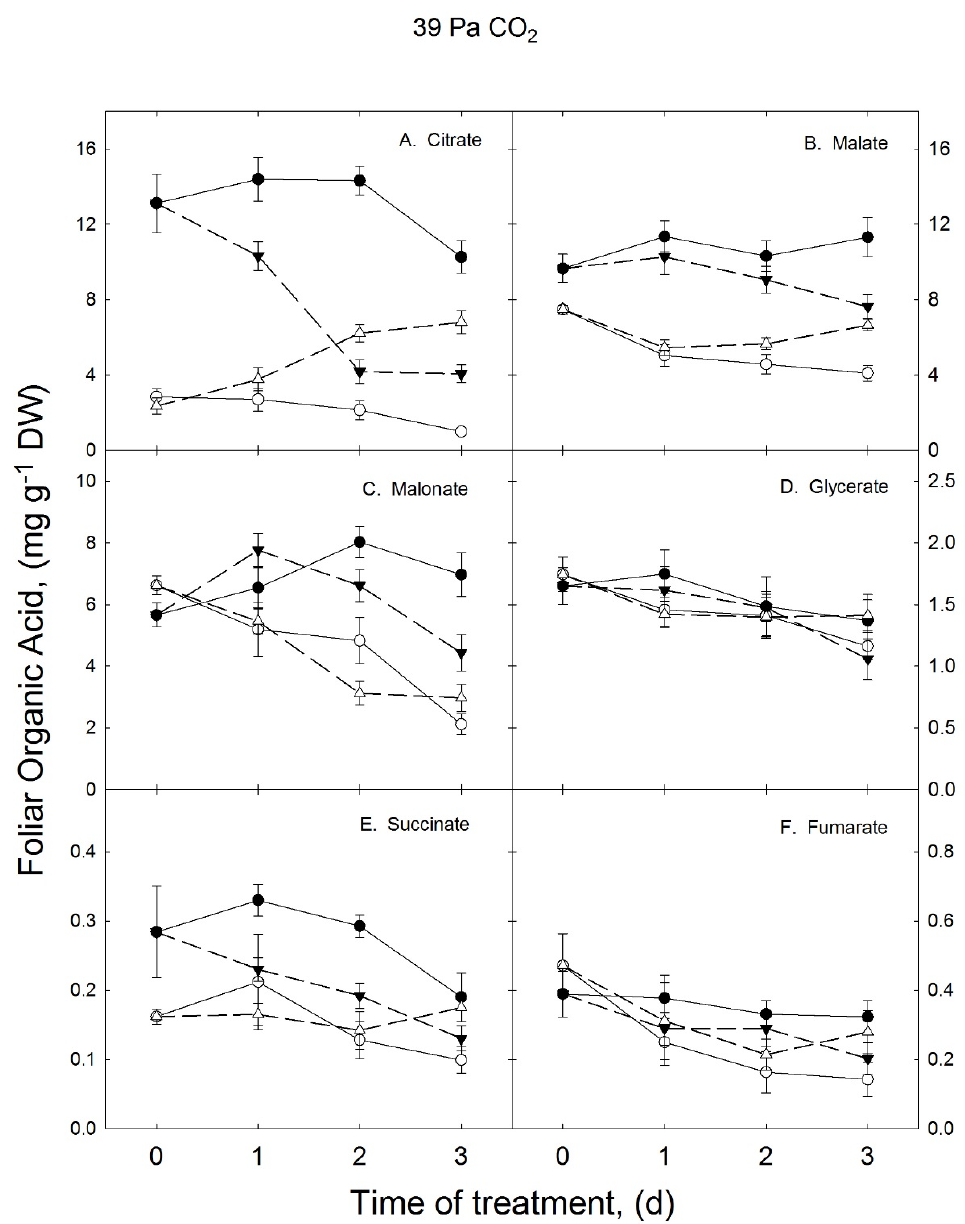
Figure 1. Effects of reciprocal changes of growth temperature on concentrations of organic acids in soybean leaflets grown with ambient CO 2 partial pressures. Plants were grown from seeds using continuous growth temperatures of 28/20 °C ( ● — ● ) or 36/28 °C ( ○ — ○ ). The first 21 or 22 DAS selected plants were transferred from the higher to lower ( ∆ ----- ∆ ) or from the lower to higher ( ▼ ----- ▼ ) growth